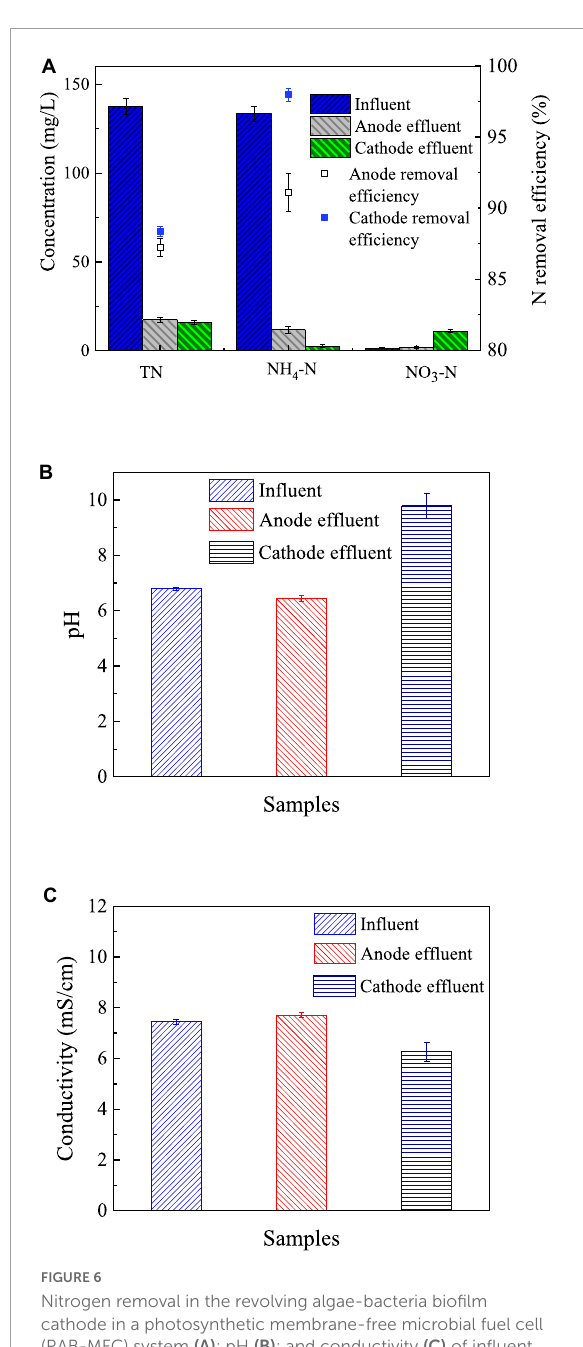
FIGURE6 Nitrogen removal in the revolving algae-bacteria biofilm cathode in a photosynthetic membrane-free microbial fuel cell (RAB-MFC) system (A) ; pH (B) ; and conductivity (C) of influent and anode and cathode effluent of the RAB-MFC. Influent chemical oxygen demand (COD) was 1,200 mg/L.